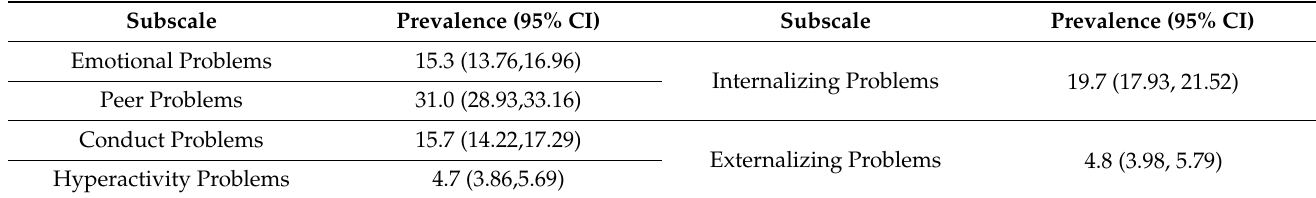
Table 2. Prevalence of mental health problems among children by subscale ( n = 4309).